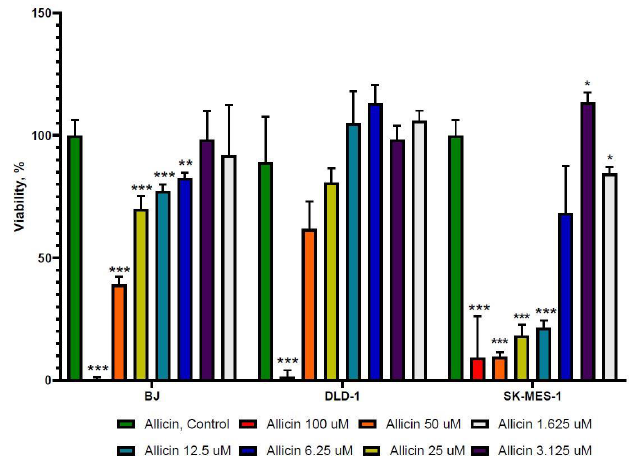
Figure 2. The viability rate analysis of allicin treatment. Allicin showed an inhibitory effect on BJ, DLD-1, and SK-MES-1 cells, with different IC 50 for each cell line, when incubated for 24 h (1.625, 3.125, 6.25, 12.5, 25, 50, and 100 µ M allicin). The results with p < 0.05 were considered statistically